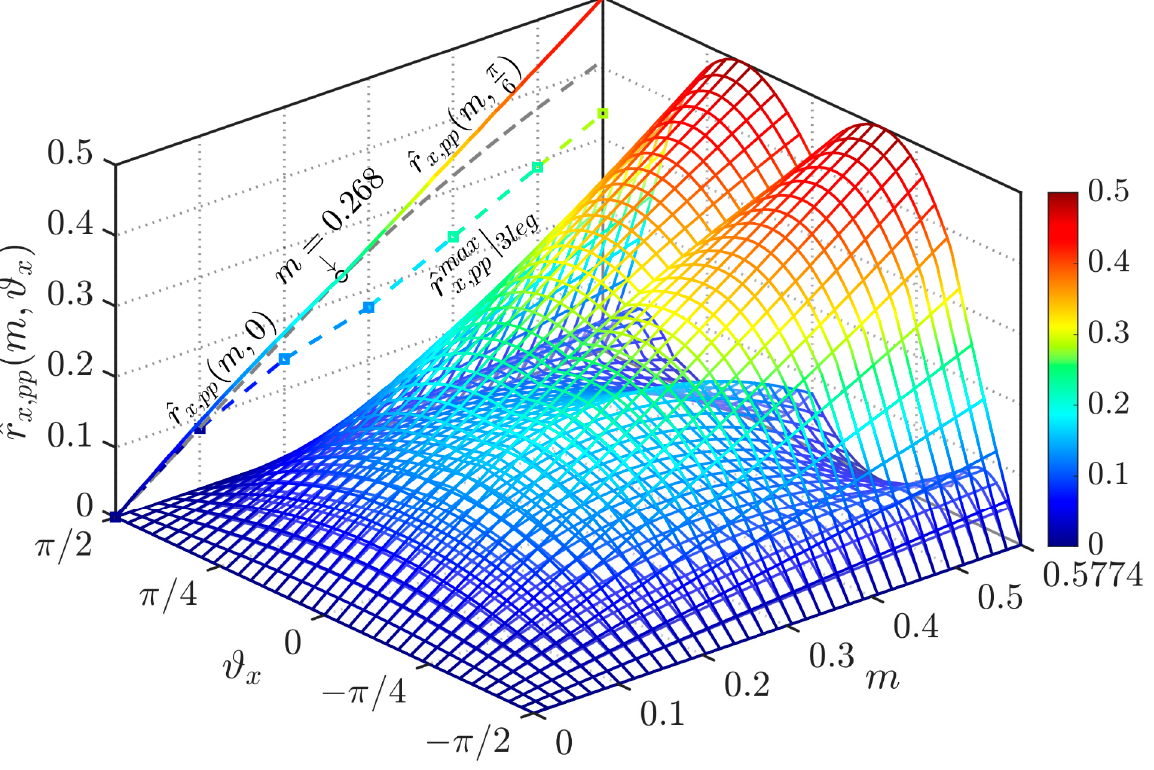
Electronics 2021 , 10 , x FOR PEER REVIEW Figure 7. Normalized primary (upper) and secondary (lower) peak-to-peak phase current ripples in case of SPWM.